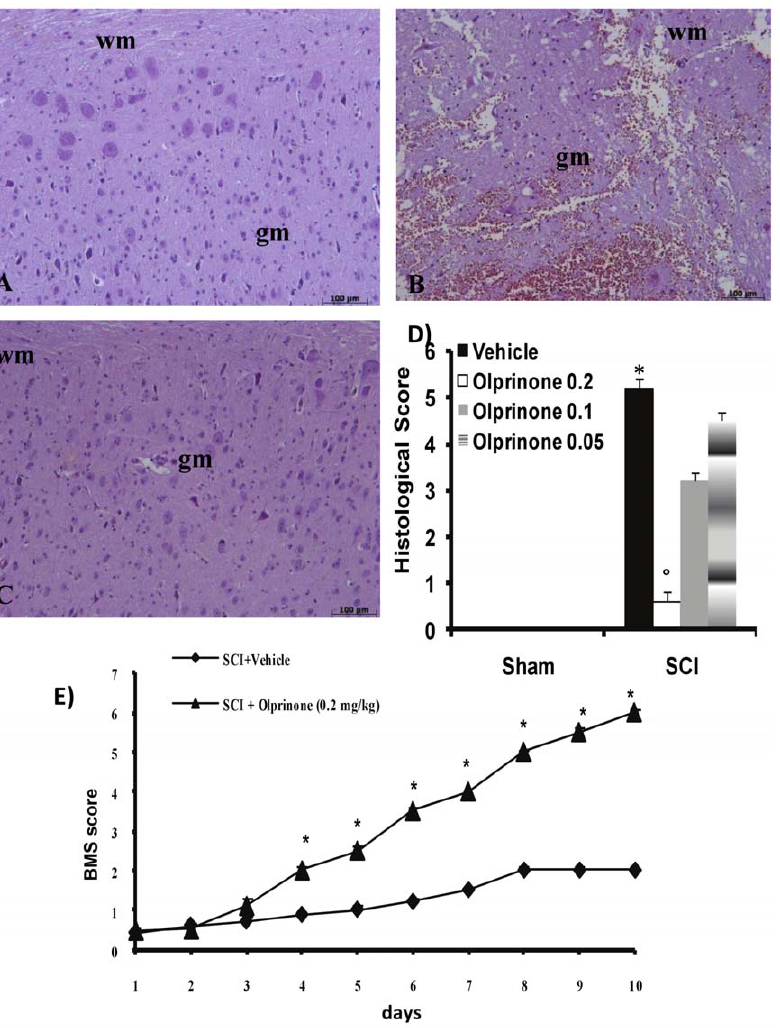
Figure 1. Effect of olprinone treatment on histological alterations of the spinal cord tissue 24 h after injury. A significant damage to the spinal cord at the perilesional area was assessed by the presence of edema as well as alteration of the white matter 24 h after injury ( B ). Notably, a significant protection from the SCI was observed in the tissue collected from olprinone treatment (0,2 mg/kg) treated mice ( C ). The histological score ( D ) was made by an independent observer and showed also a dose-response study with 0,05-0,1-0,2 mg/kg olprinone. wm: White matter; gm: gray matter. This figure is representative of at least 3 experiments performed on different experimental days. The degree of motor disturbance ( E ) was assessed every day until 10 days after SCI using the Basso Mouse Scale. Treatment with olprinone (0,2 mg/kg) reduces the motor disturbance after SCI. Values shown are mean 6 s.e. mean of 10 mice for each group. u p , 0.01 vs. SCI .